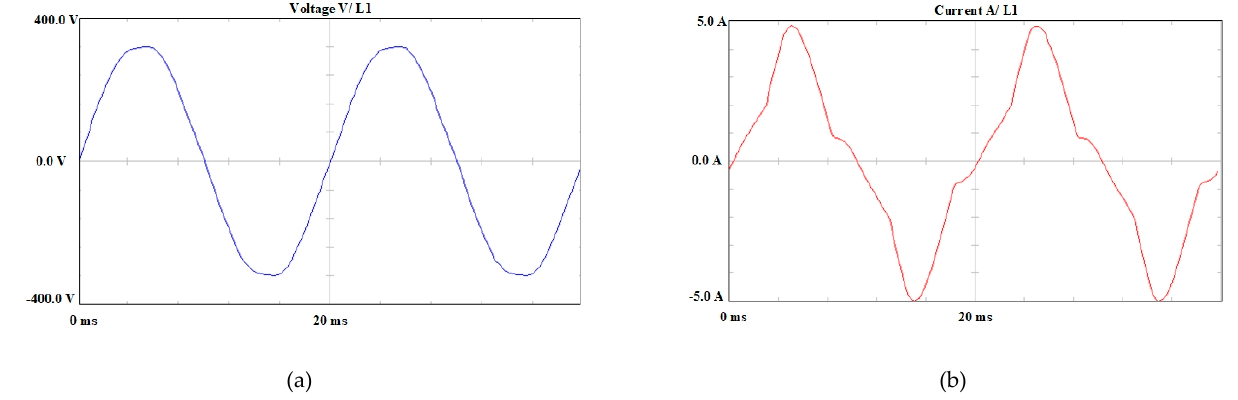
Figure 7. Set of household equipment: ( a ) input voltage waveform; ( b ) input current waveform.